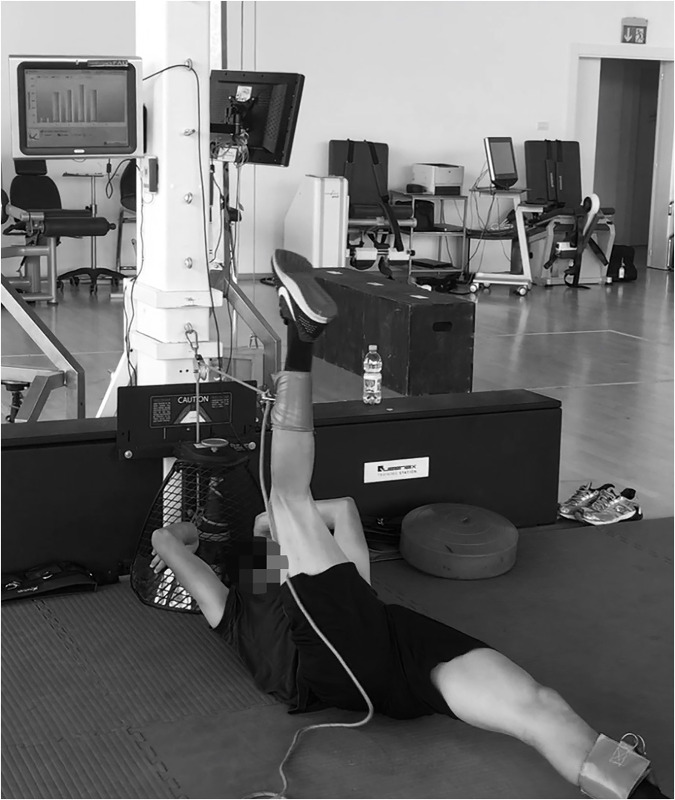
Hip extension in versa pulley.